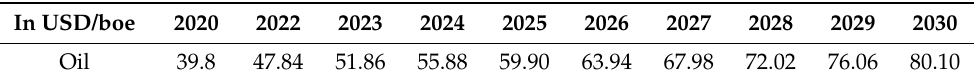
Table 2. International oil fuel prices assumptions based on the REF2020 scenario [31]. Values are linearly interpolated on a per-year